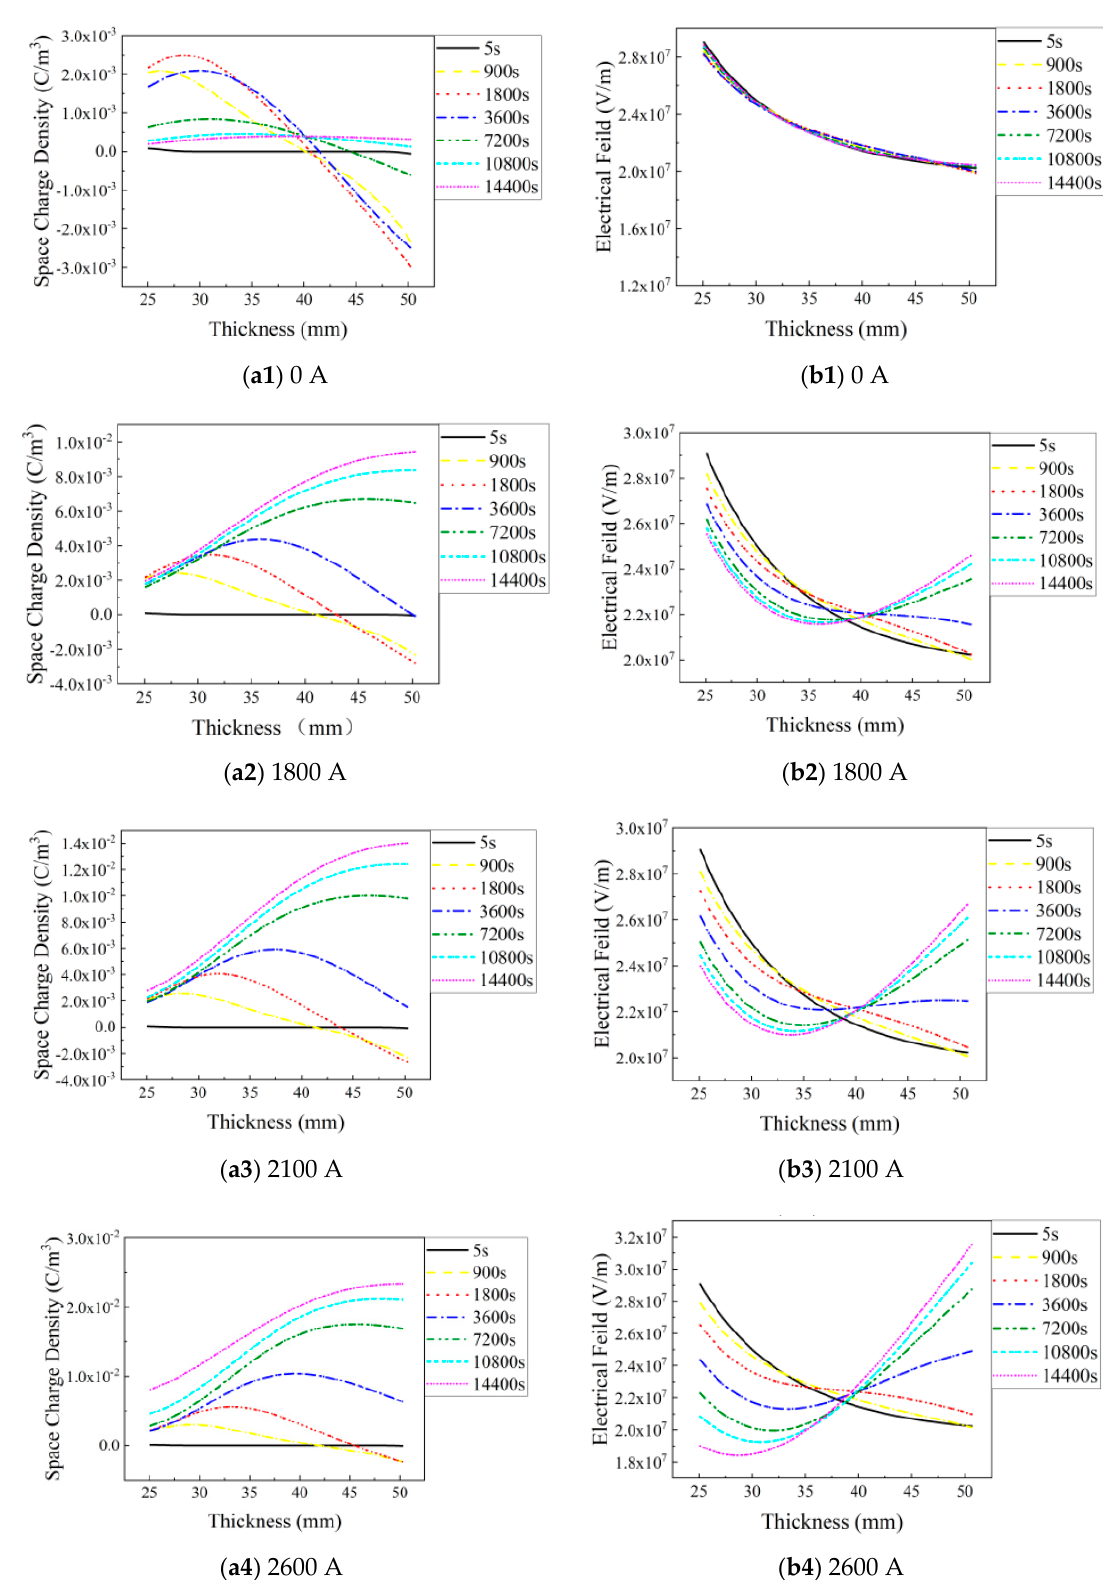
Figure 12. Simulation results of space charge distribution ( a1 - a4 ) and electric field distribution ( b1 - b4 ) in HVDC insulation when the trap density is 80 × 10 19 m − 3 , trap depth is 0.94 eV with load current varying from 0 to 2600 A under 592 kV.